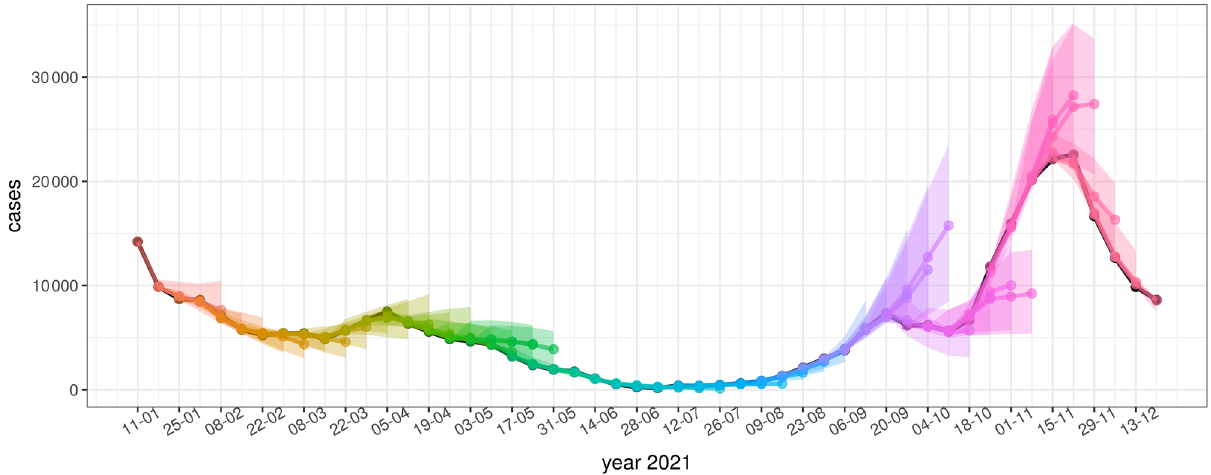
Figure 4. Model forecasts of weekly incidence of COVID-19 confirmed cases. Black dots represent actual data. The colored dots represent predictions for 1, 2, 3 and 4 weeks ahead, the colored areas represent their confidence intervals. Forecasts from the same date are represented with the same color.